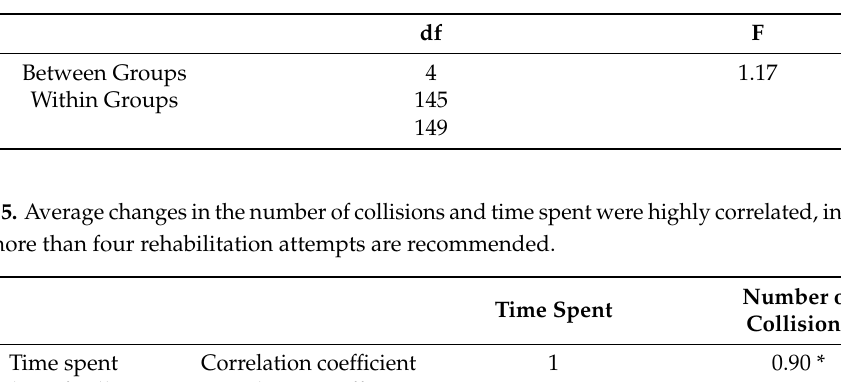
Table 4. There was no significant difference in the time spent conducting rehabilitation by round.